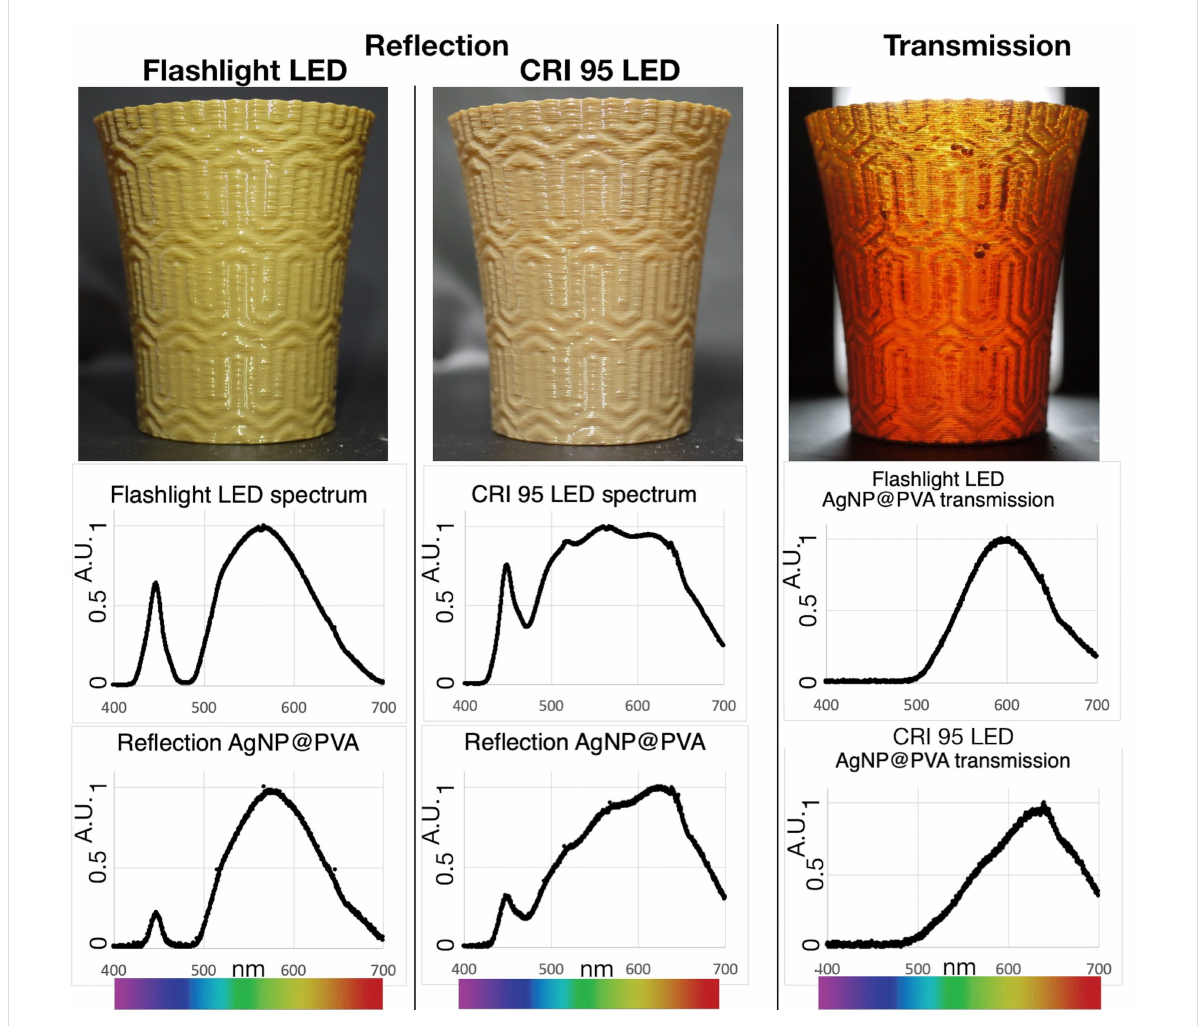
Figure 2: 3D printed AgNP@PVA cup under reflection and transmission. When the cup is illuminated by a flashlight LED it reflects a greenish colour as evident from the reflectance spectrum. However, when illuminated by a broader coverage white light as the CRI 95 LED, it reflects mostly near the red region of the spectrum. In transmission, the nanocomposite shows a red coloration, independently by the illumination